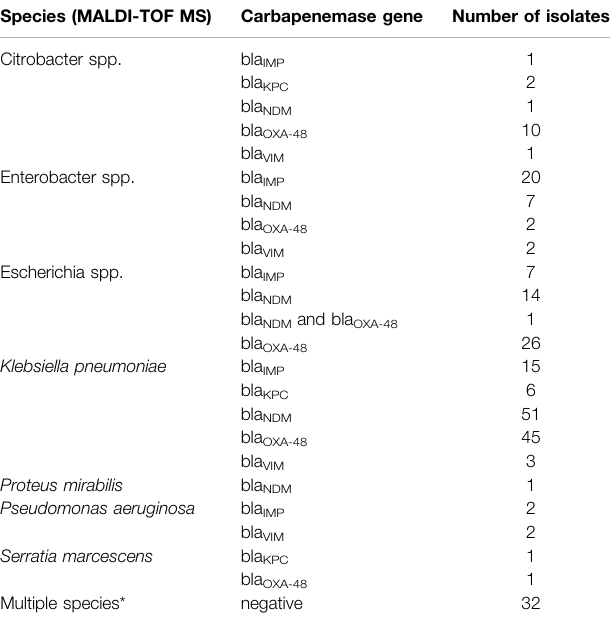
TABLE 3 | Clinical Enterobacteriaceae isolates used in this study. Species (MALDI-TOF MS) Carbapenemase gene Number of isolates Citrobacter